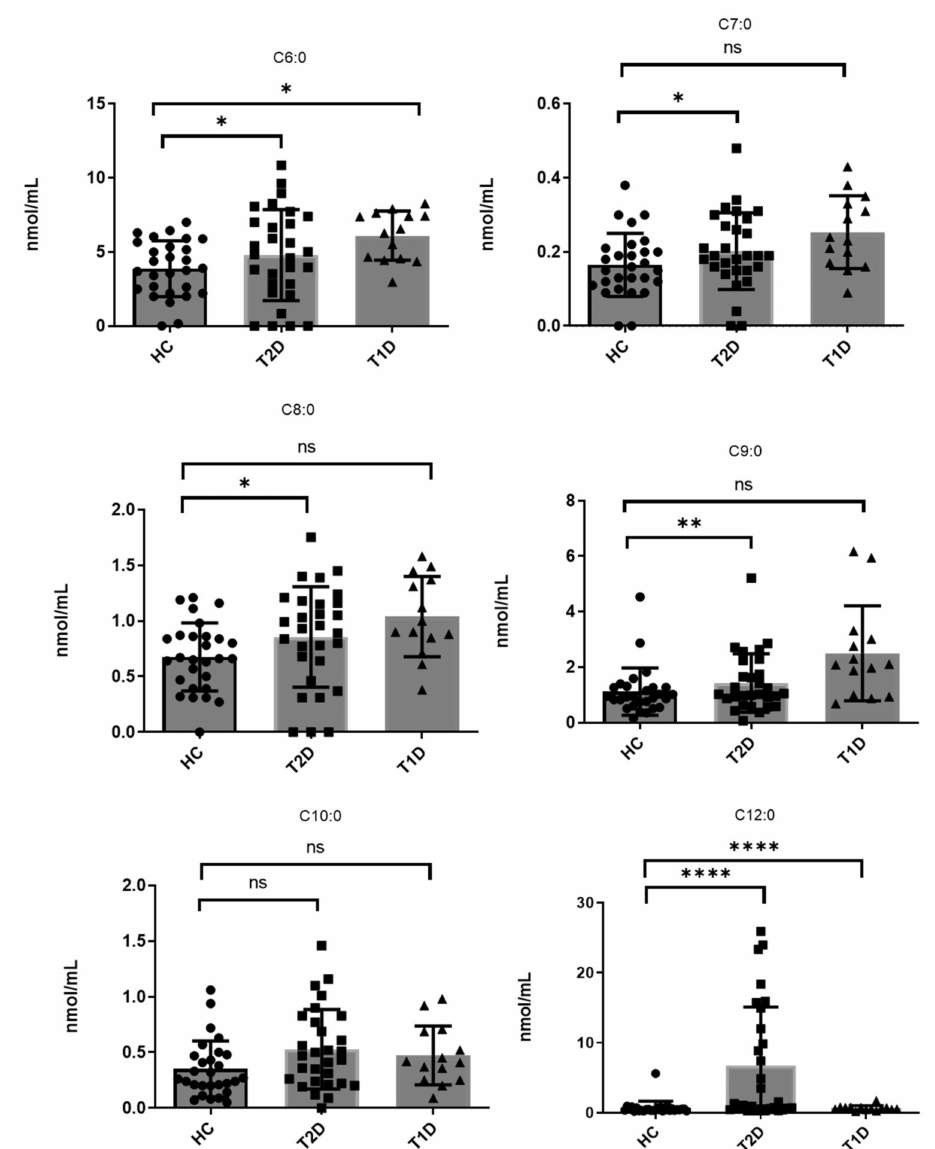
Figure 5. Comparison of plasma concentrations (nmol/mL) of C6:0, C7:0, C8:0, C9:0, C10:0 and C12:0 between healthy controls and T2D and T1D patients. Graphs were created using GraphPad Prism 9.2.0. One-way ANOVA statistical analysis was performed for each separate set comparing to control. ns (not significant): p > 0.05. * p < 0.05, ** p < 0.01, **** p <